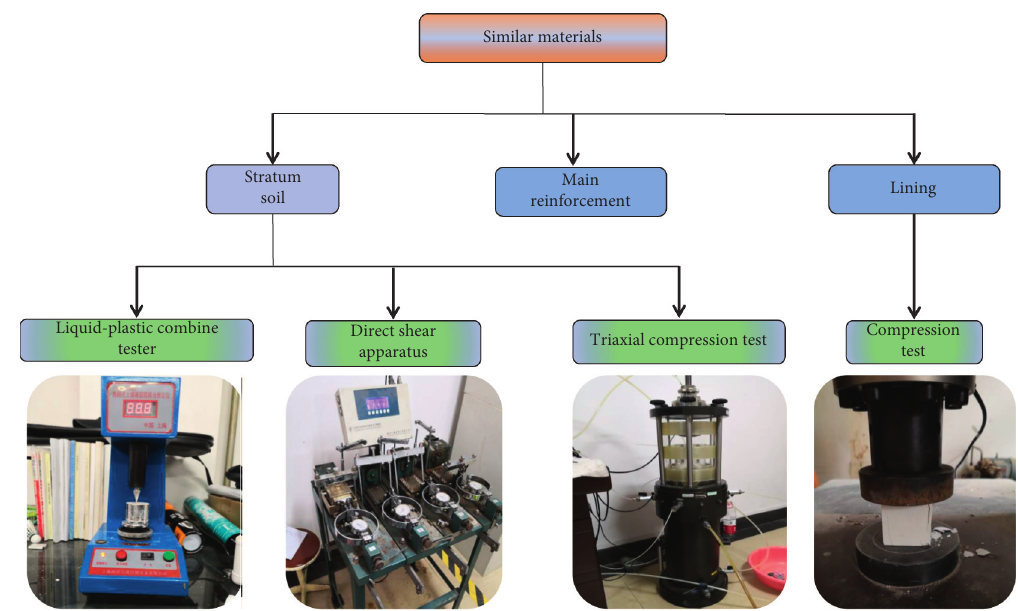
Figure 2: Equipment for optimization tests of similar material parameters. Table 2: Prototype and model materials.